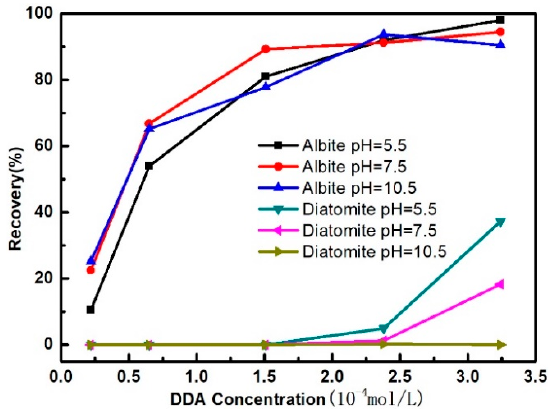
Figure 2. Flotation recovery as a function of DDA collector concentration at varying pH.